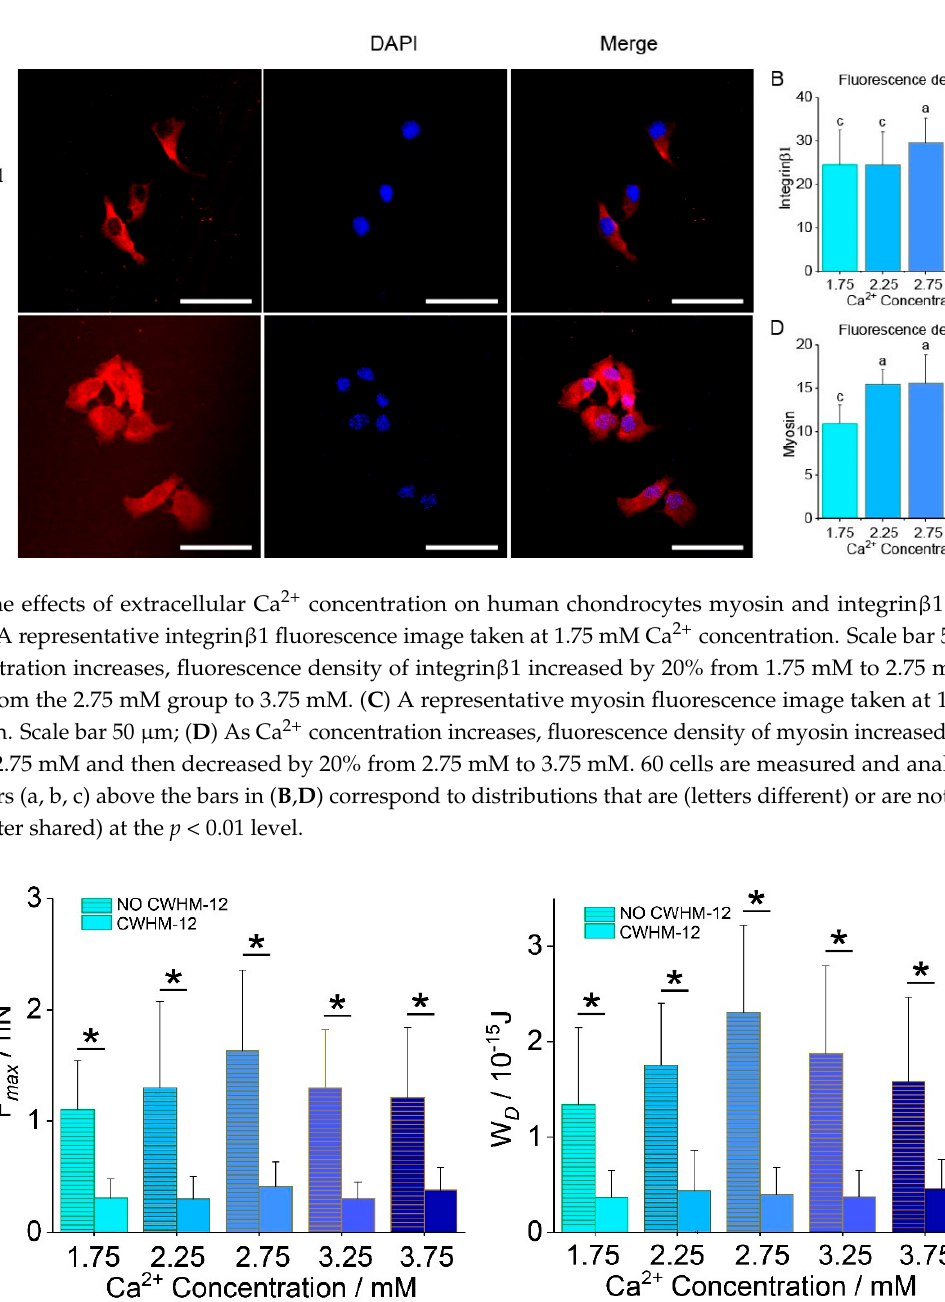
Figure 7. The adhesion between human chondrocytes and ECM after CWHM-12 treatment at different extracellular Ca 2 + concentrations. The value of F max in five groups was between 300 ± 200 pN (2.25 mM) and 410 ± 217 pN (2.75 mM) ( A ). The value of W d in five groups was between 3.6 ± 2.8 × 10 − 16 J (1.75 mM) and 4.6 ± 3.1 × 10 − 16 J (3.75 mM) ( B ). Compared with non-treatment groups, F max in CWHM-12 groups dramatically decreased. *: p < 0.05, 60 cells were measured and analyzed in each